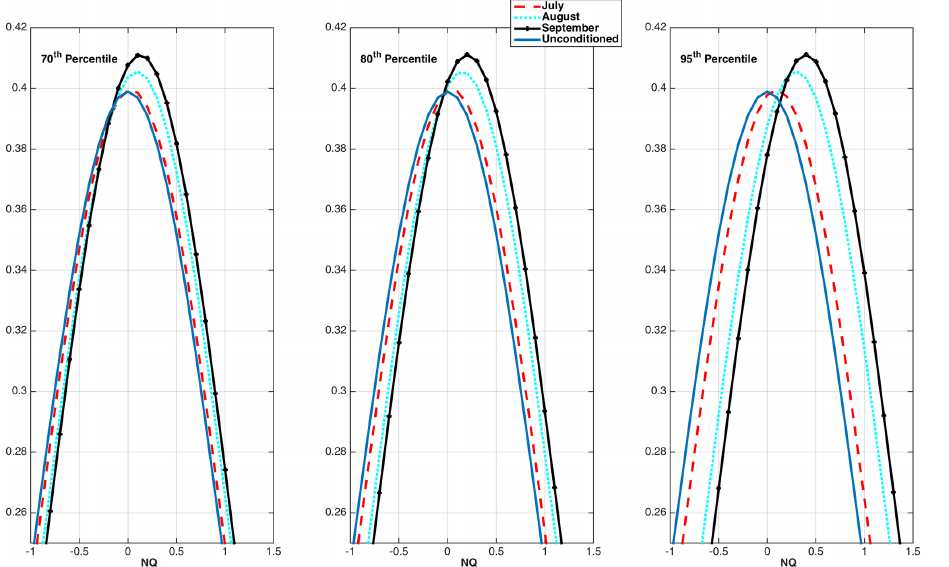
Figure 3. Probability distribution functions of the normalized dependent variable (NQ p ) conditioned to the occurrence of the 70th, 80th and 95th percentiles of the normalized variables in the pre-flood season.